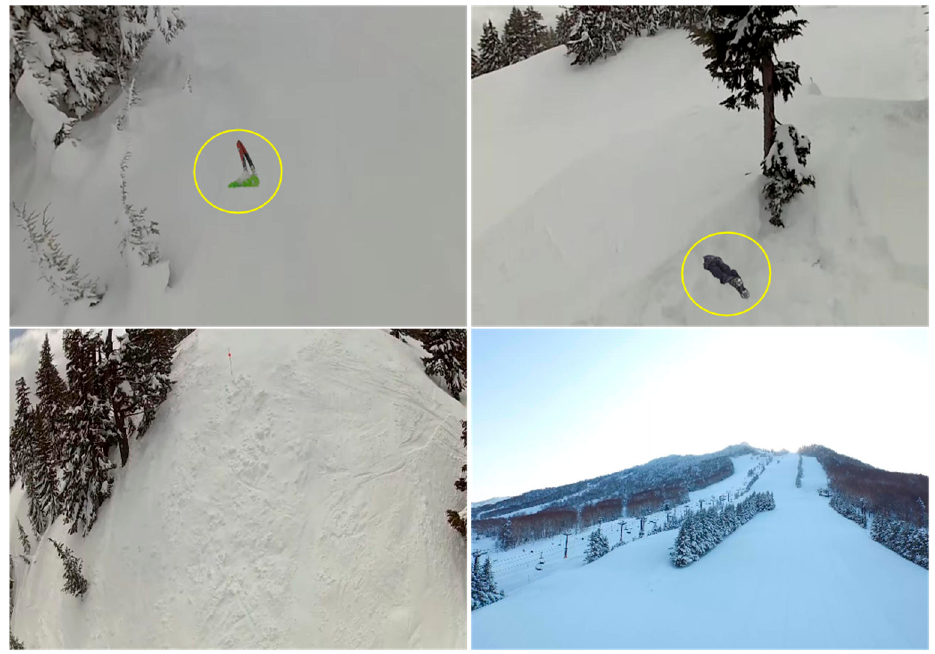
Figure 5. Example of positive ( top ) and negative ( bottom ) images from the first dataset. Objects of interest (partially buried skis ( left ) and top half-buried victim ( right )) are marked with yellow circles.